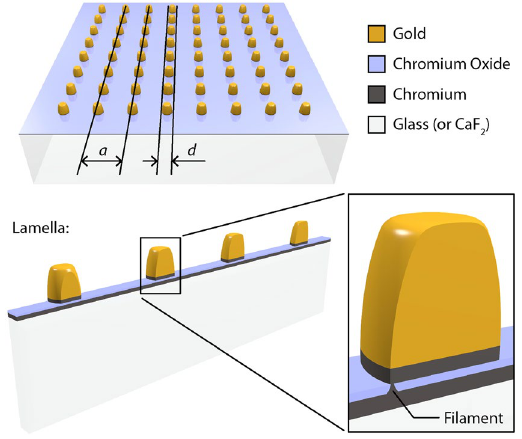
Figure 1. Device schematic. Plasmonic ND arrays were fabricated on glass (or CaF 2 ) substrates covered in a thin Cr layer. Thin lamellas, intersecting multiple NDs, were extracted from arrays in order to perform STEM measurement of conductive CrO x